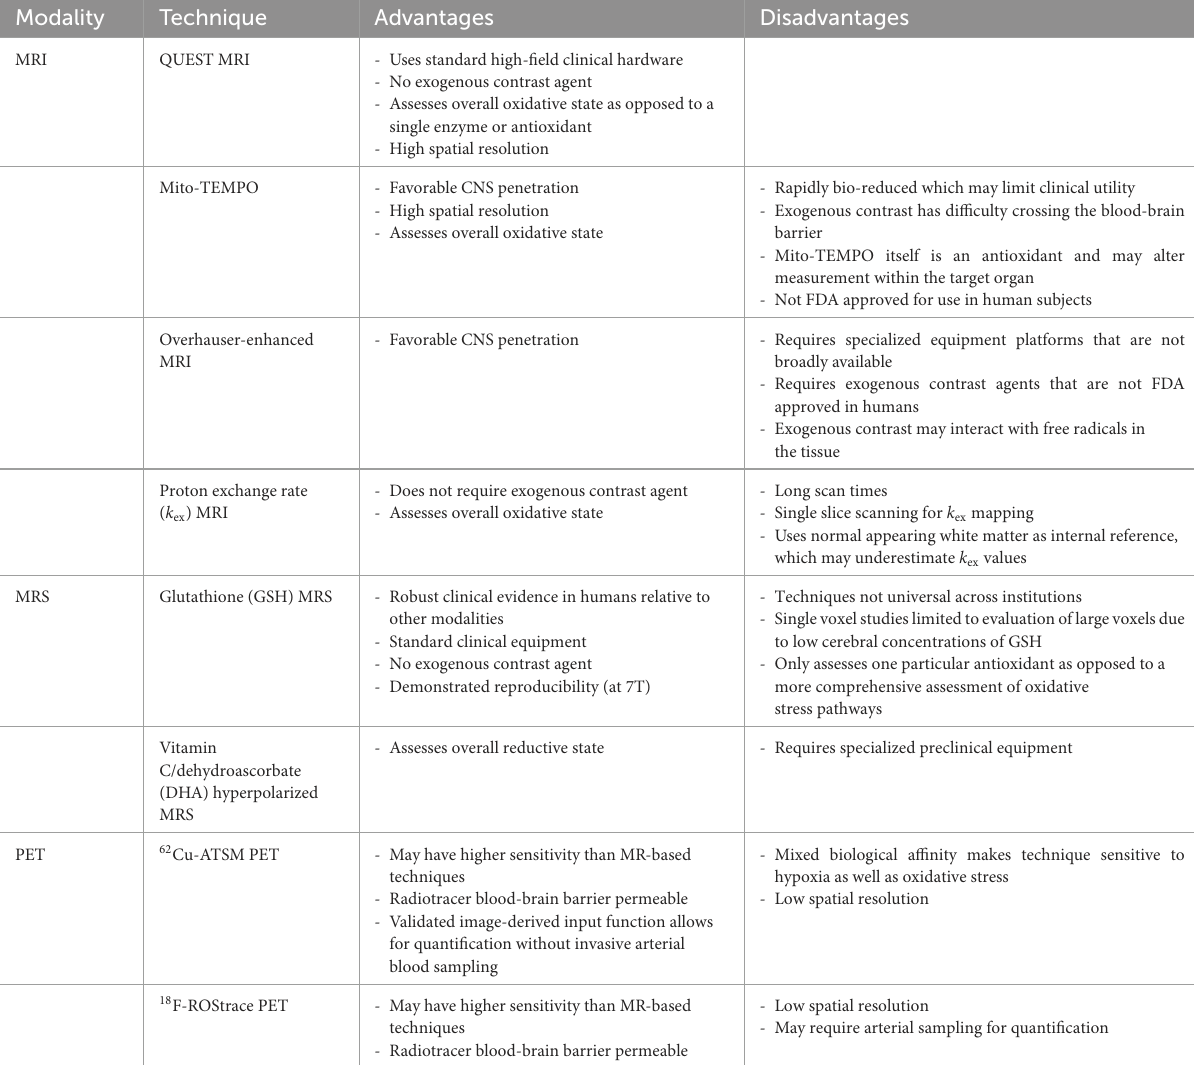
TABLE 2 Advantages and